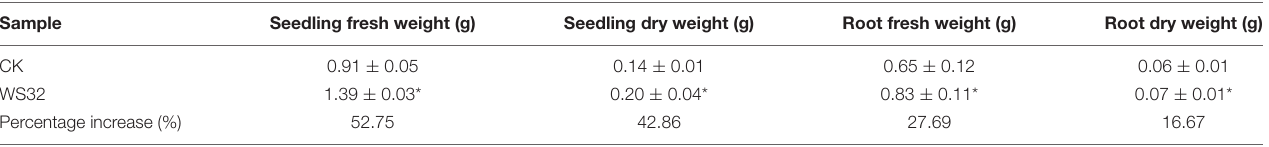
TABLE 2 | Effects of WS32 on the growth of wheat seedlings collected on day 25 in rhizobox experiments.